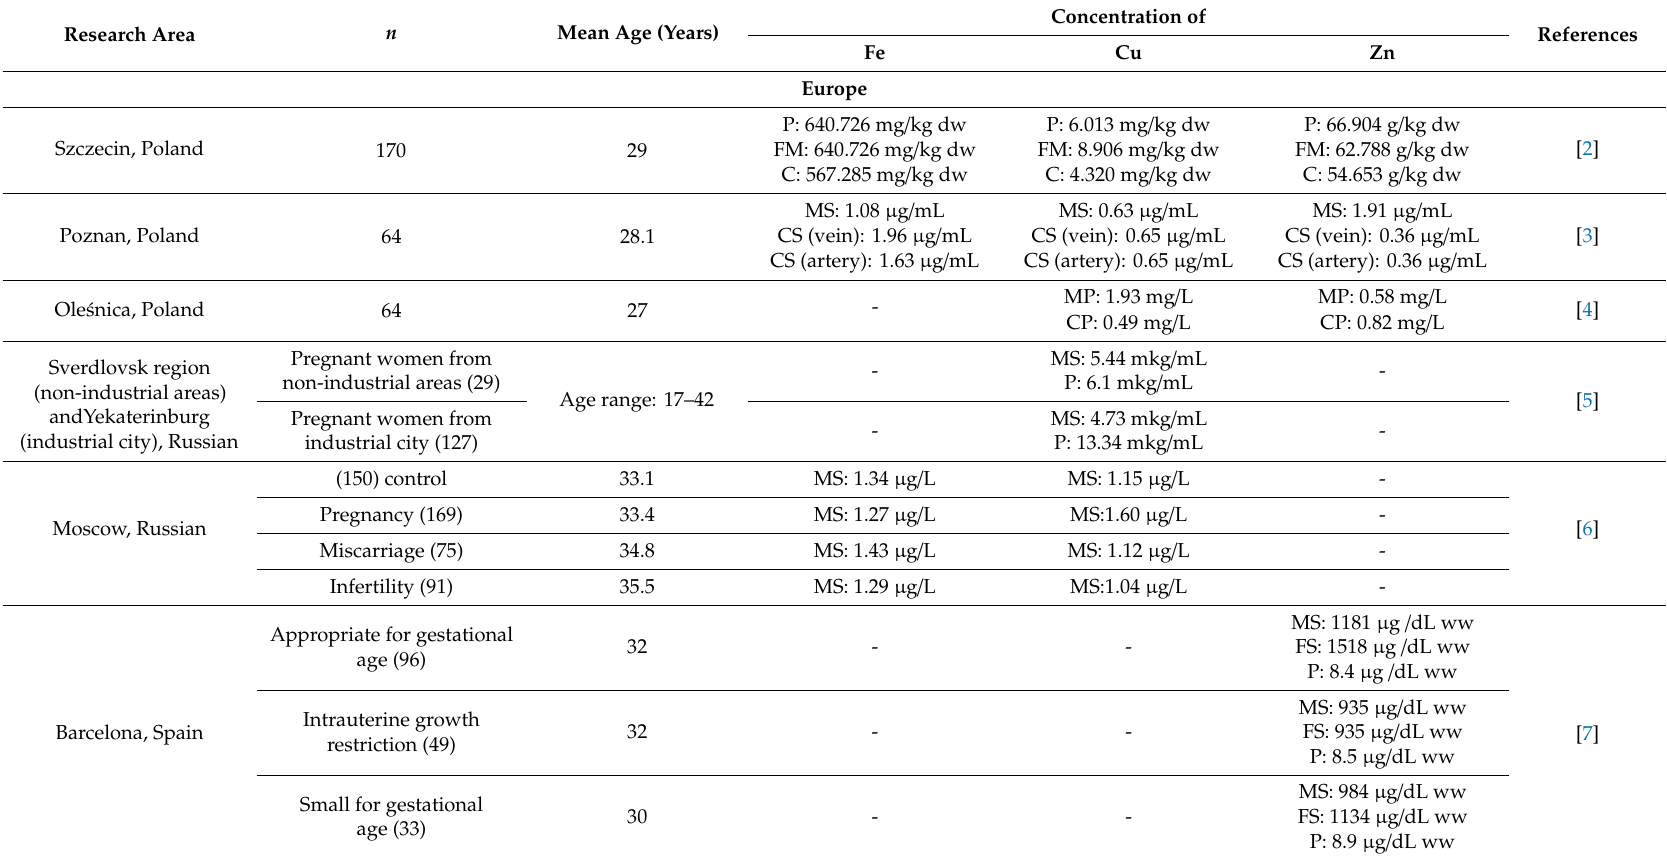
Table 1. The concentrations of iron (Fe), copper (Cu), and zinc (Zn) in di ff erent biological materials collected from women during childbirth ( n , number of women; FM, fetal membrane; FS, fetal serum; C, cord; CB, cord blood; CS, cord serum; CP, cord plasma MB, maternal blood; MS, maternal serum; MP, maternal plasma; P, placenta; dw, dry weight; ww, wet